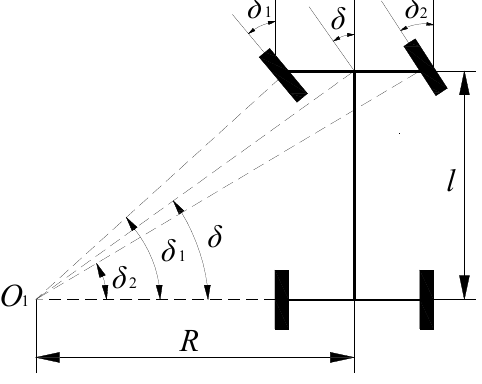
Figure 4. Ackerman principle. Figure 4. Ackerman